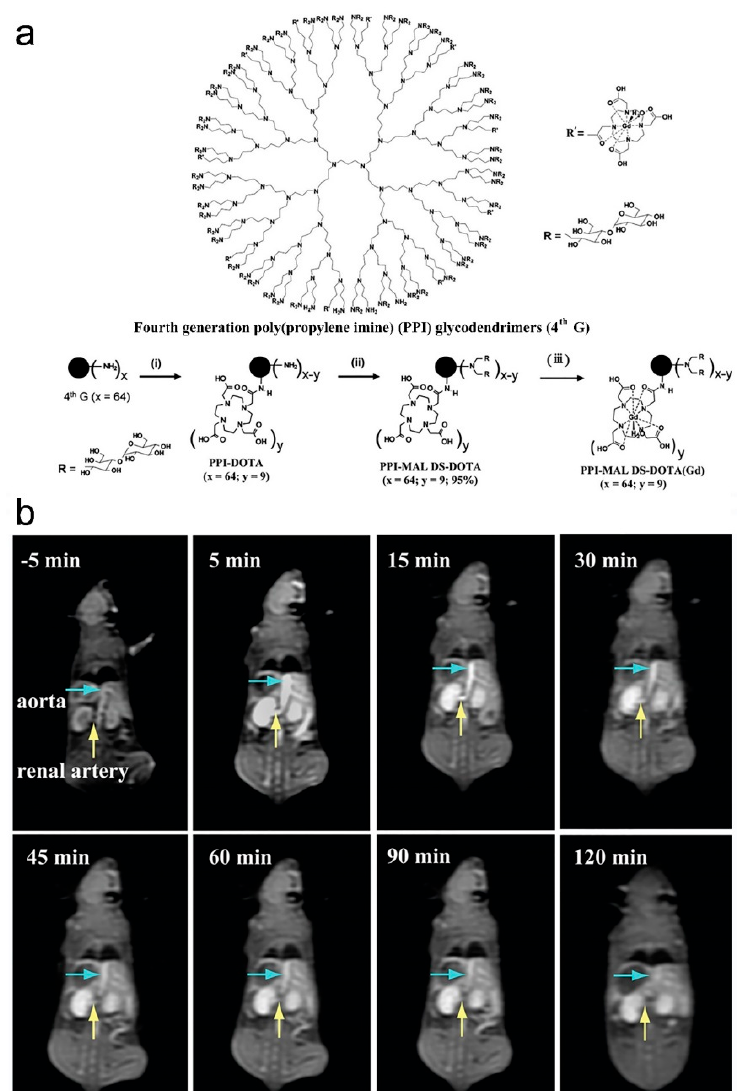
Figure 3. ( a ) Schematic illustration of the approach used to synthesize the PPI-MAL DS-DOTA(Gd), and ( b ) T 1 -weighted MR images of mouse aorta and renal artery at 5 min before injection ( − 5 min) and at 15, 30, 45, 60, 90, and 120 min post-injection of the PPI-MAL DS-DOTA(Gd) ([Gd 3+ ] = 2 mg mL − 1 in 0.2 mL saline through tail vein, adapted from Shi et al. 2016 [36], Copyright 2016 The Royal Society of Chemistry and reproduced with permission).